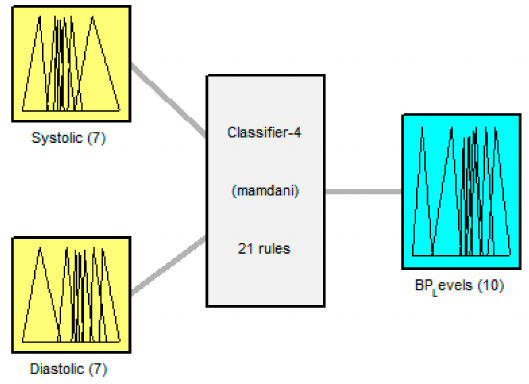
Figure 16. Structure of the fuzzy logic classifier 4.